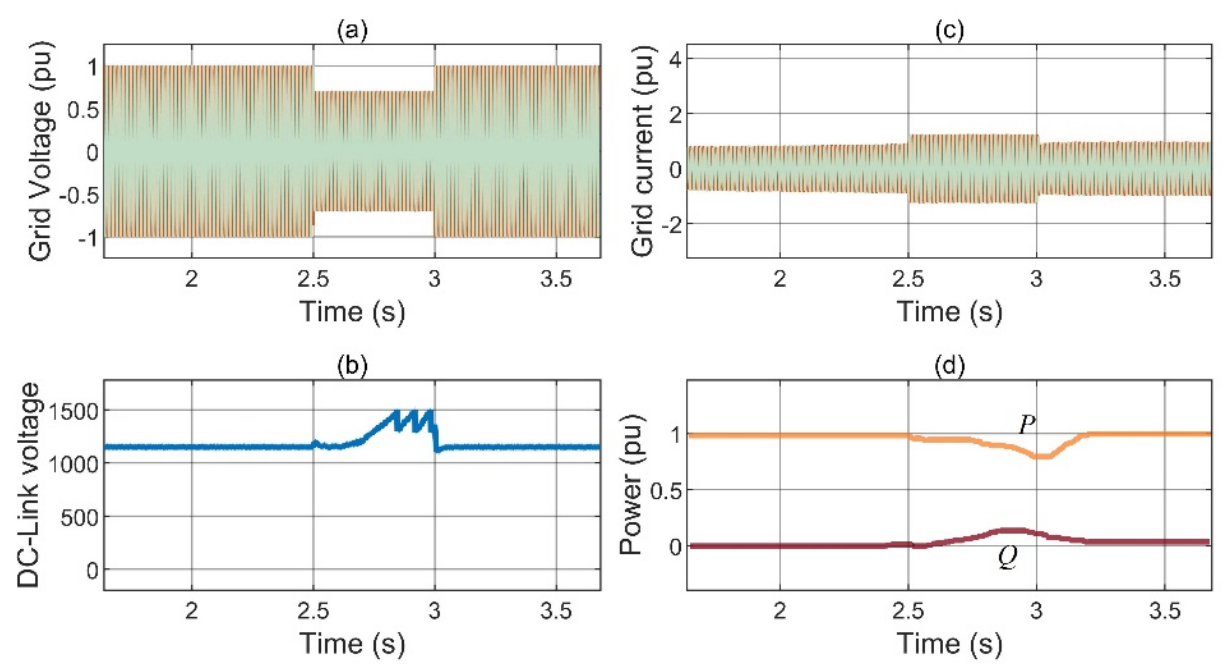
Figure 13. Increased rotor speed during fault.